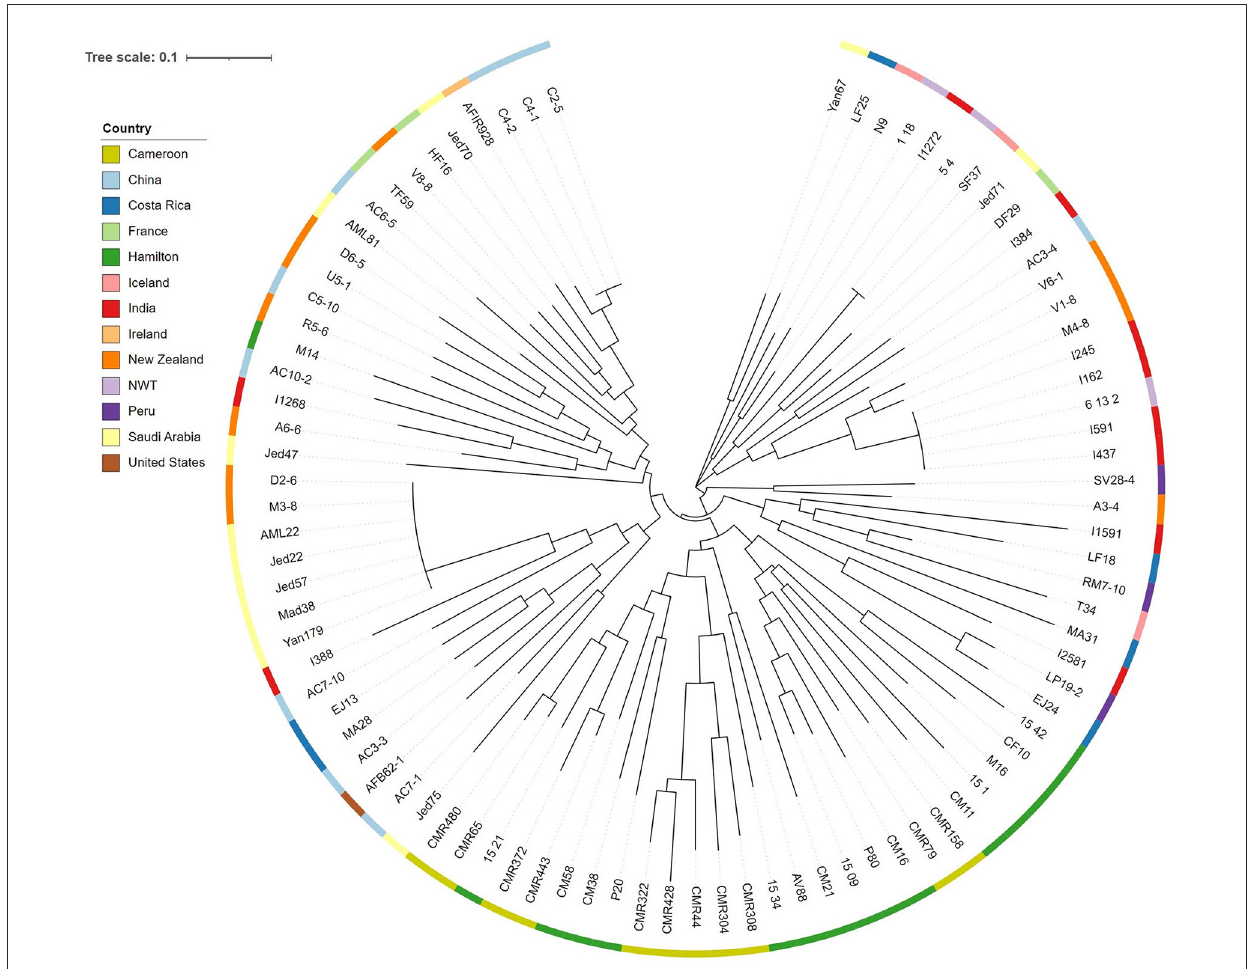
FIGURE10 Neighbor joining tree among strains of A. fumigatus based on STR genotypes. The phylogram was constructed using the Bruvo’s genetic distances at nine STR loci. Color strips at each individual node represent the country of